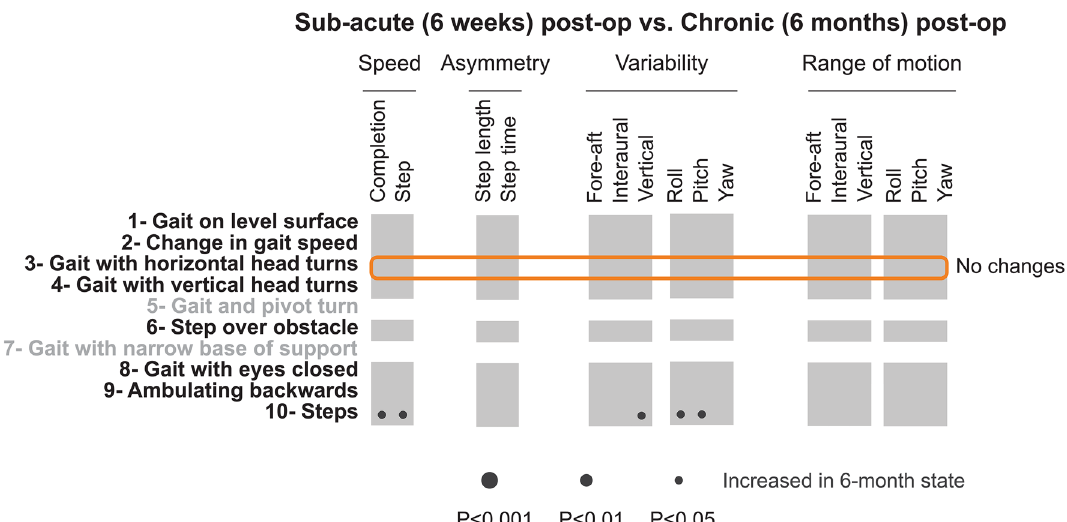
Figure 5. Comparison of objective head movement kinematics of sub-acute and chronic post-op patients. Each column corresponds to a kinematic measure, while rows indicated FGA tasks. Dark circles show increased measure > 6 months after the surgery. The radius of the circle indicates the level of significance of the difference between the two groups. Orange box indicates the FGA task in which patients altered their kinematics the most from pre-op and sub-acute post-op